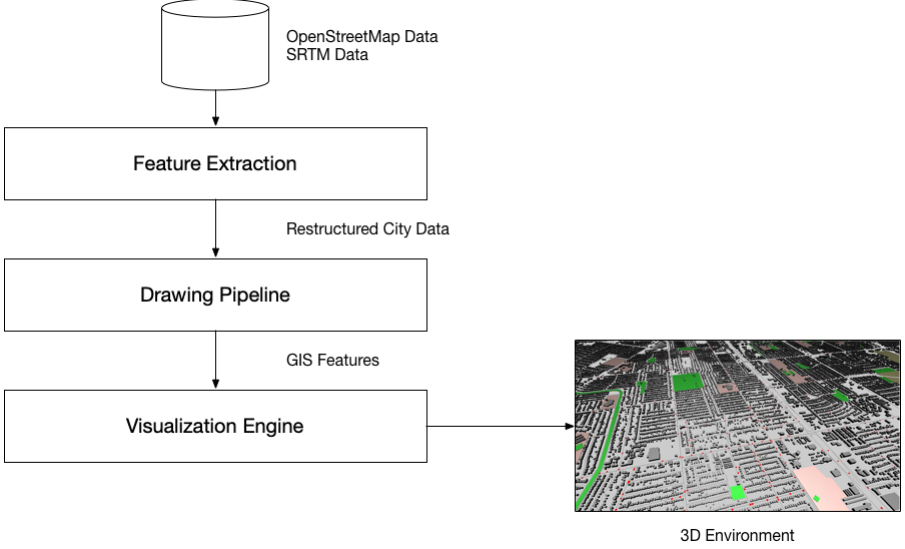
Figure 1. Different phases of City